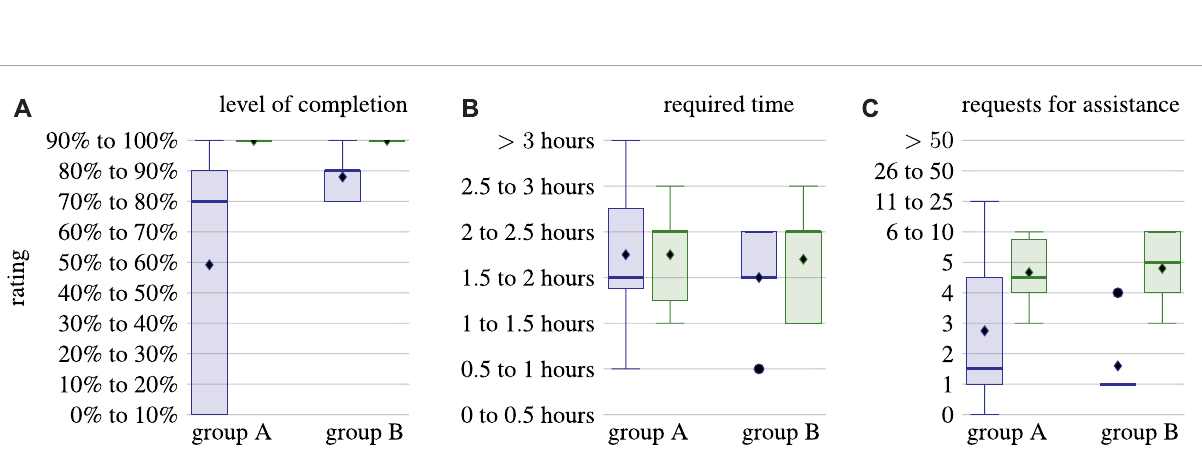
study design and applied methods are described in detail before the results are presented afterward in section 3.3.2